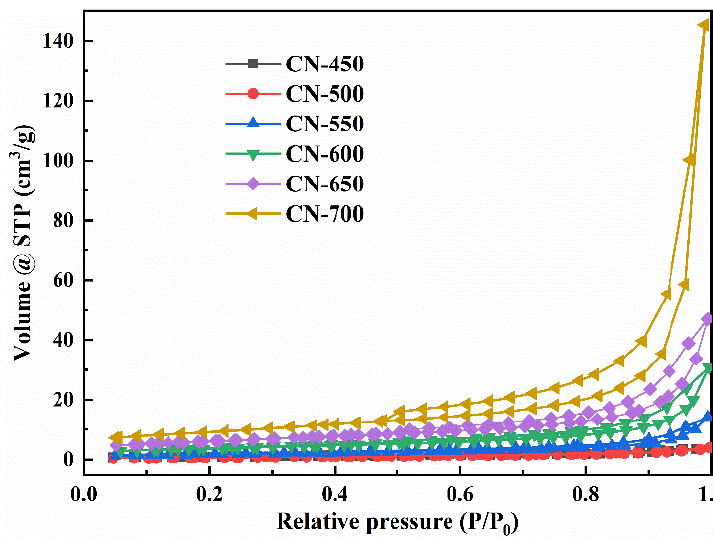
Figure 7. N 2 adsorption – desorption isotherms. Table 3. S BET and V pore of samples.